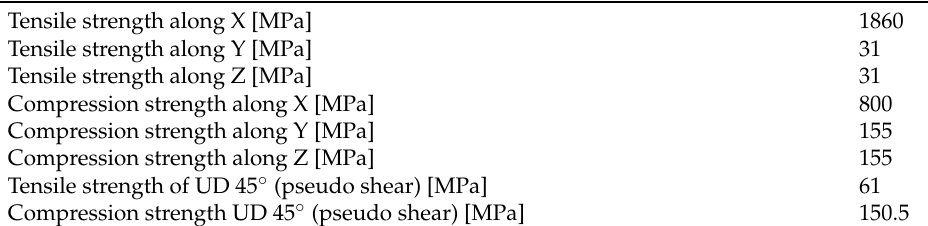
Table 3. The ultimate stresses of T700S/2592 [34] .